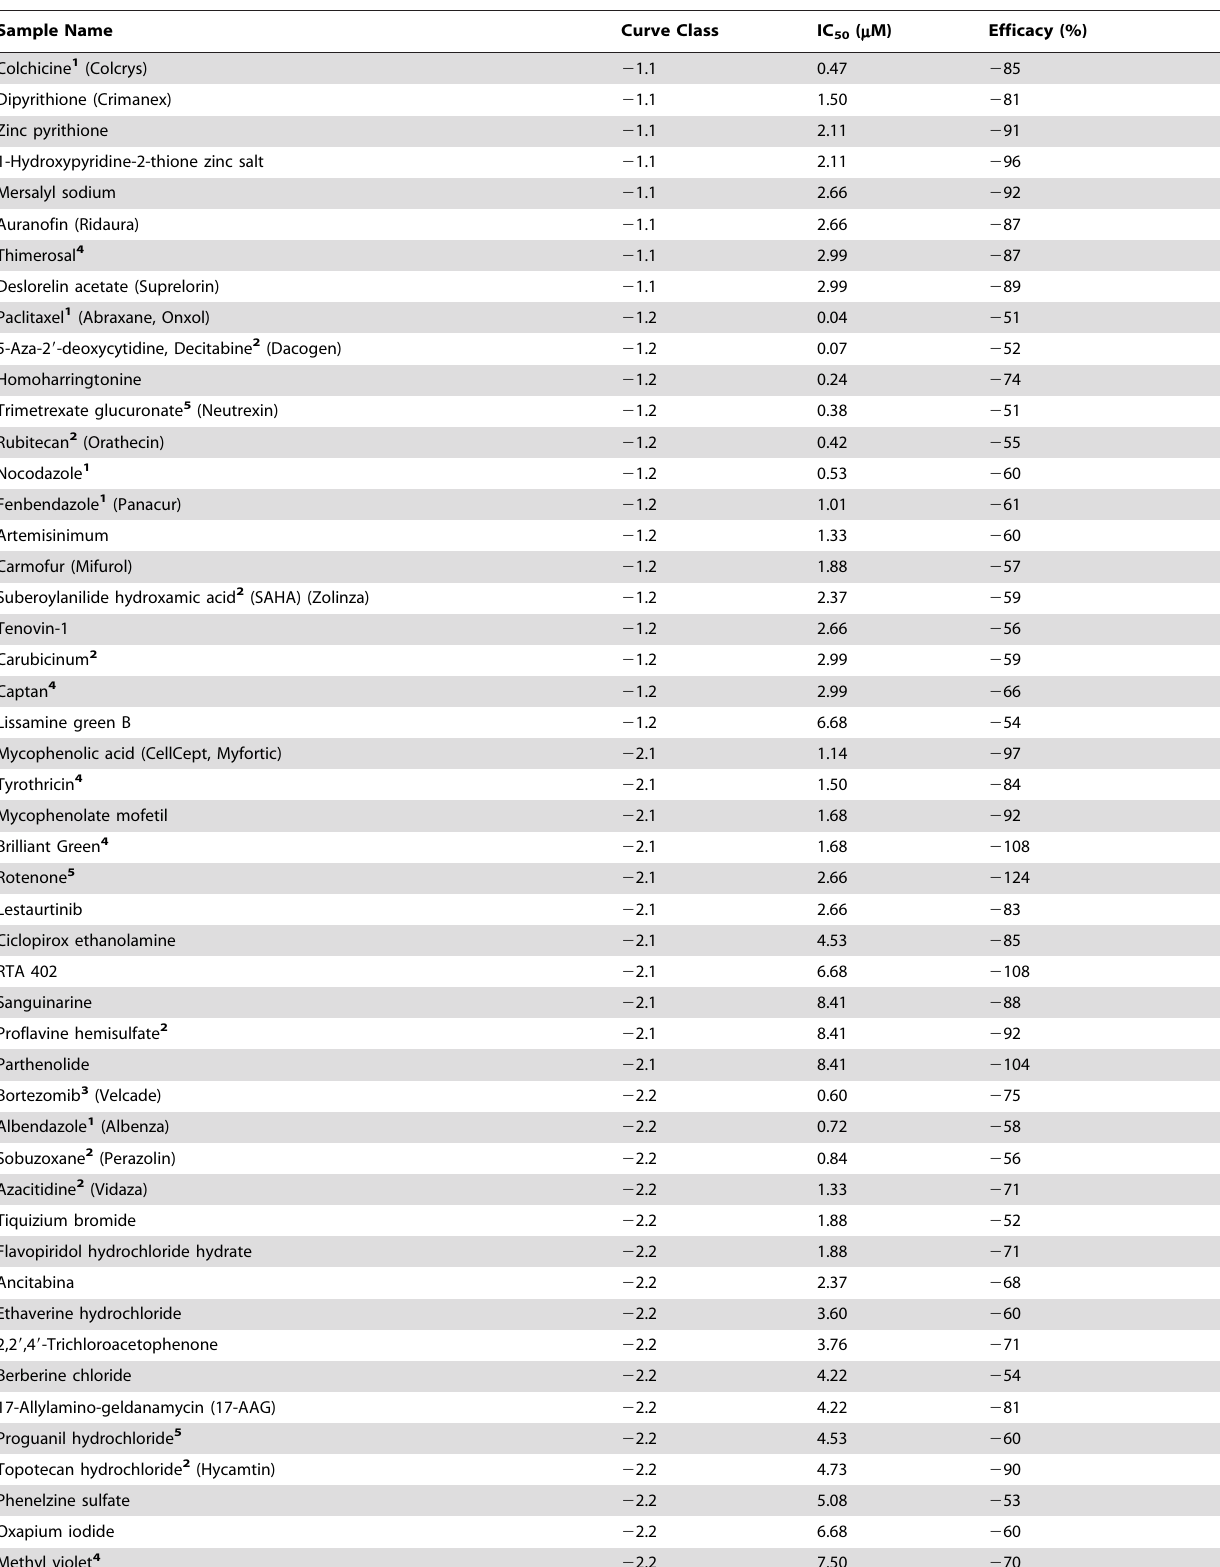
Table 1. Top-ranked compounds (hits) with high confidence antiproliferative activity in MTT PHEO cells.